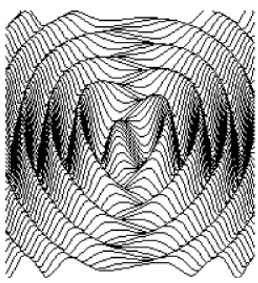
Figure 6.4 . Surface of one of the components A x (x,y,z = 0 ) for the vortex solution